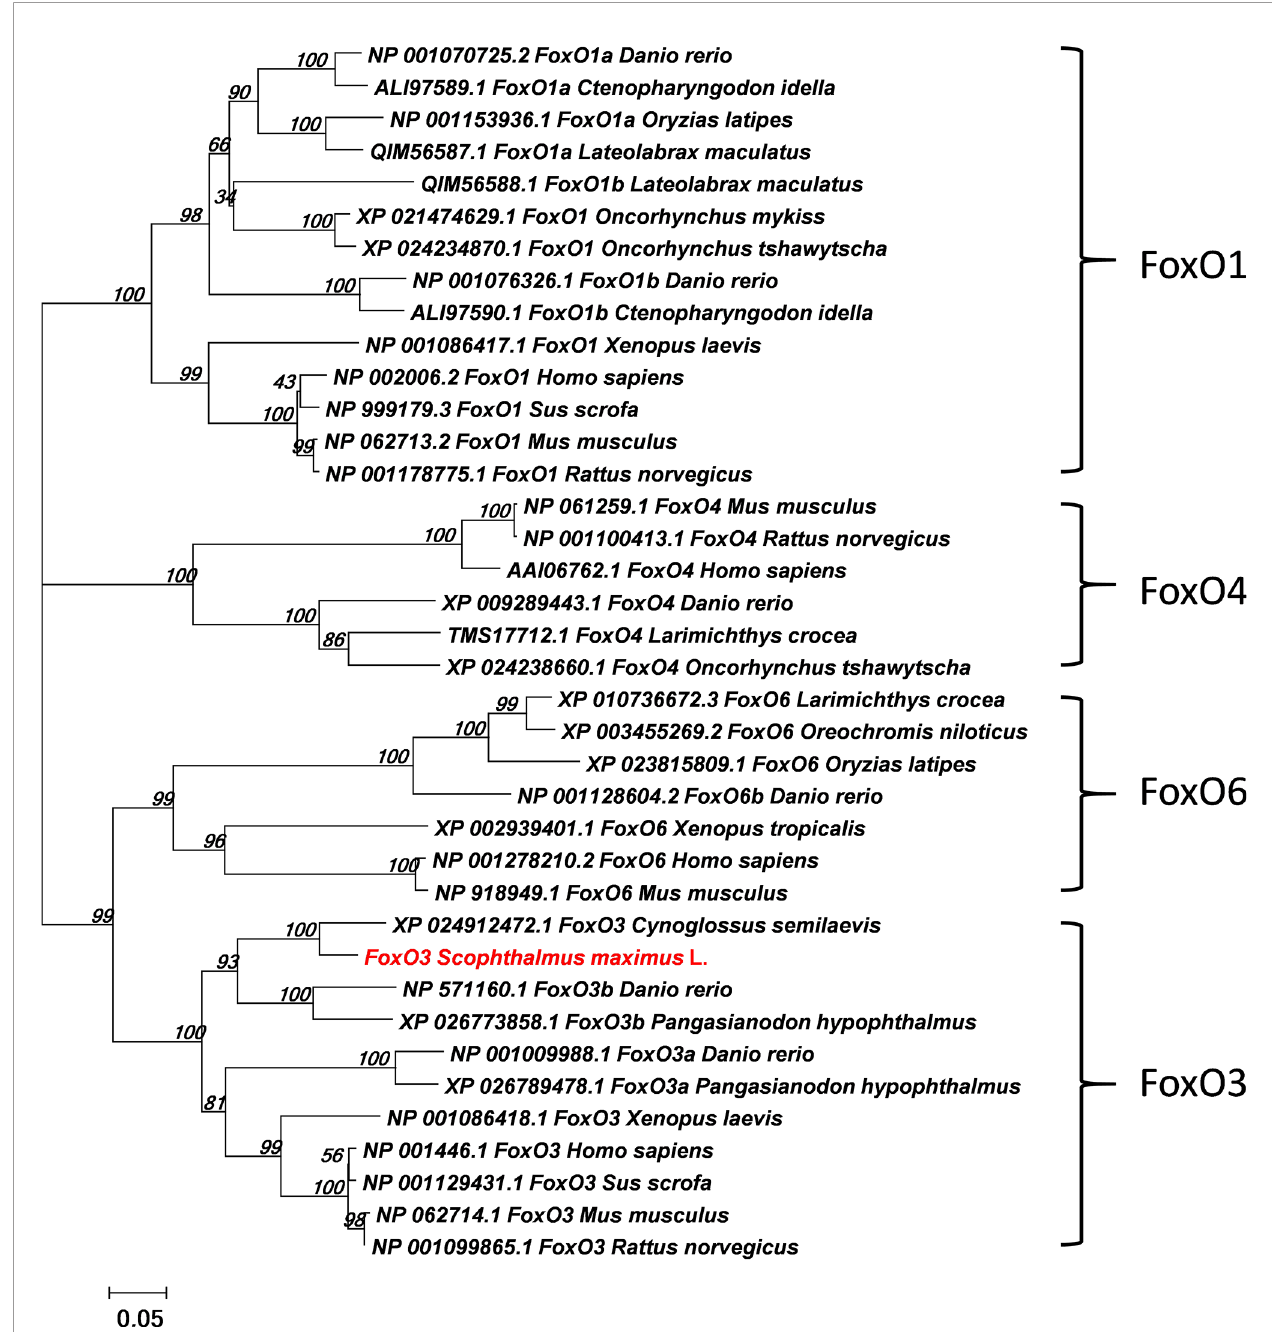
FIGURE 1 | Phylogenetic tree comparing turbot ( Scophthalmus maximus L.) foxo with amino acid sequences from other species. The phylogenetic tree was constructed using the Neighbor-Joining method in MEGA5. The branch length is proportional to the amino acid substitution rate per site. The numbers represent the frequencies (%) with which the tree topology presented was replicated after 1000